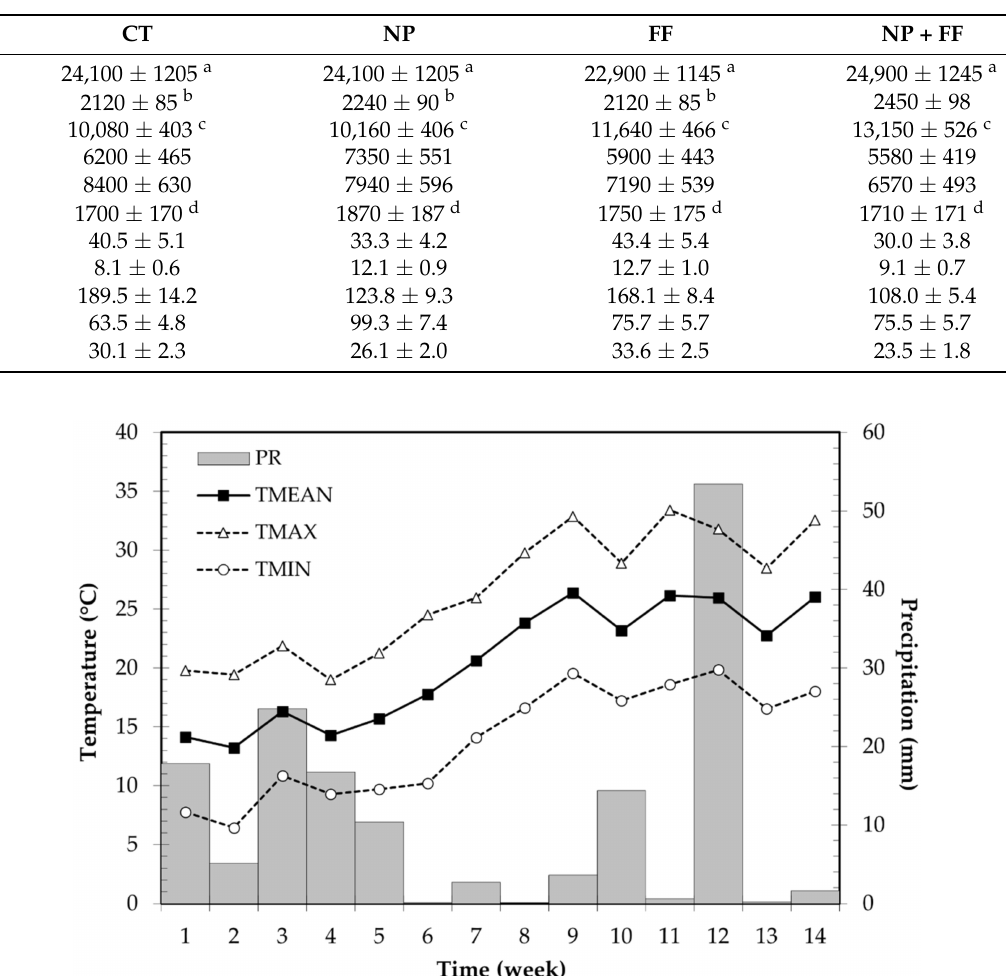
Figure 6. Meteorological data of growing season in the study area. PR: